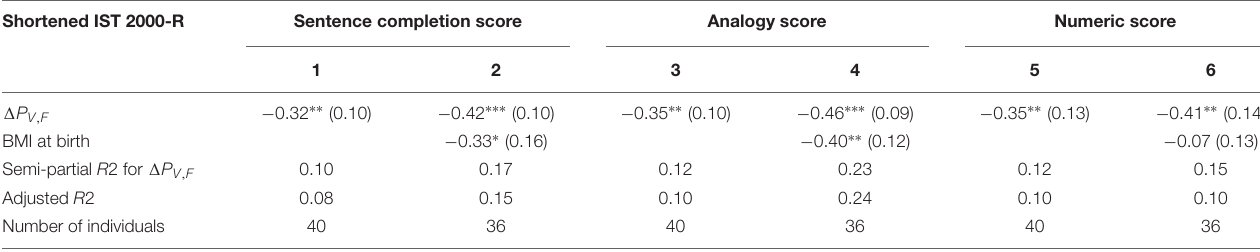
TABLE 3 | The results of linear regression models of the test scores from each of the tree subcomponents of the shortened IST 2000-R test and the difference between single-sensory power and double-sensory power ( (cid:49) P V , F ). Shortened IST 2000-R Sentence completion score Analogy score Numeric